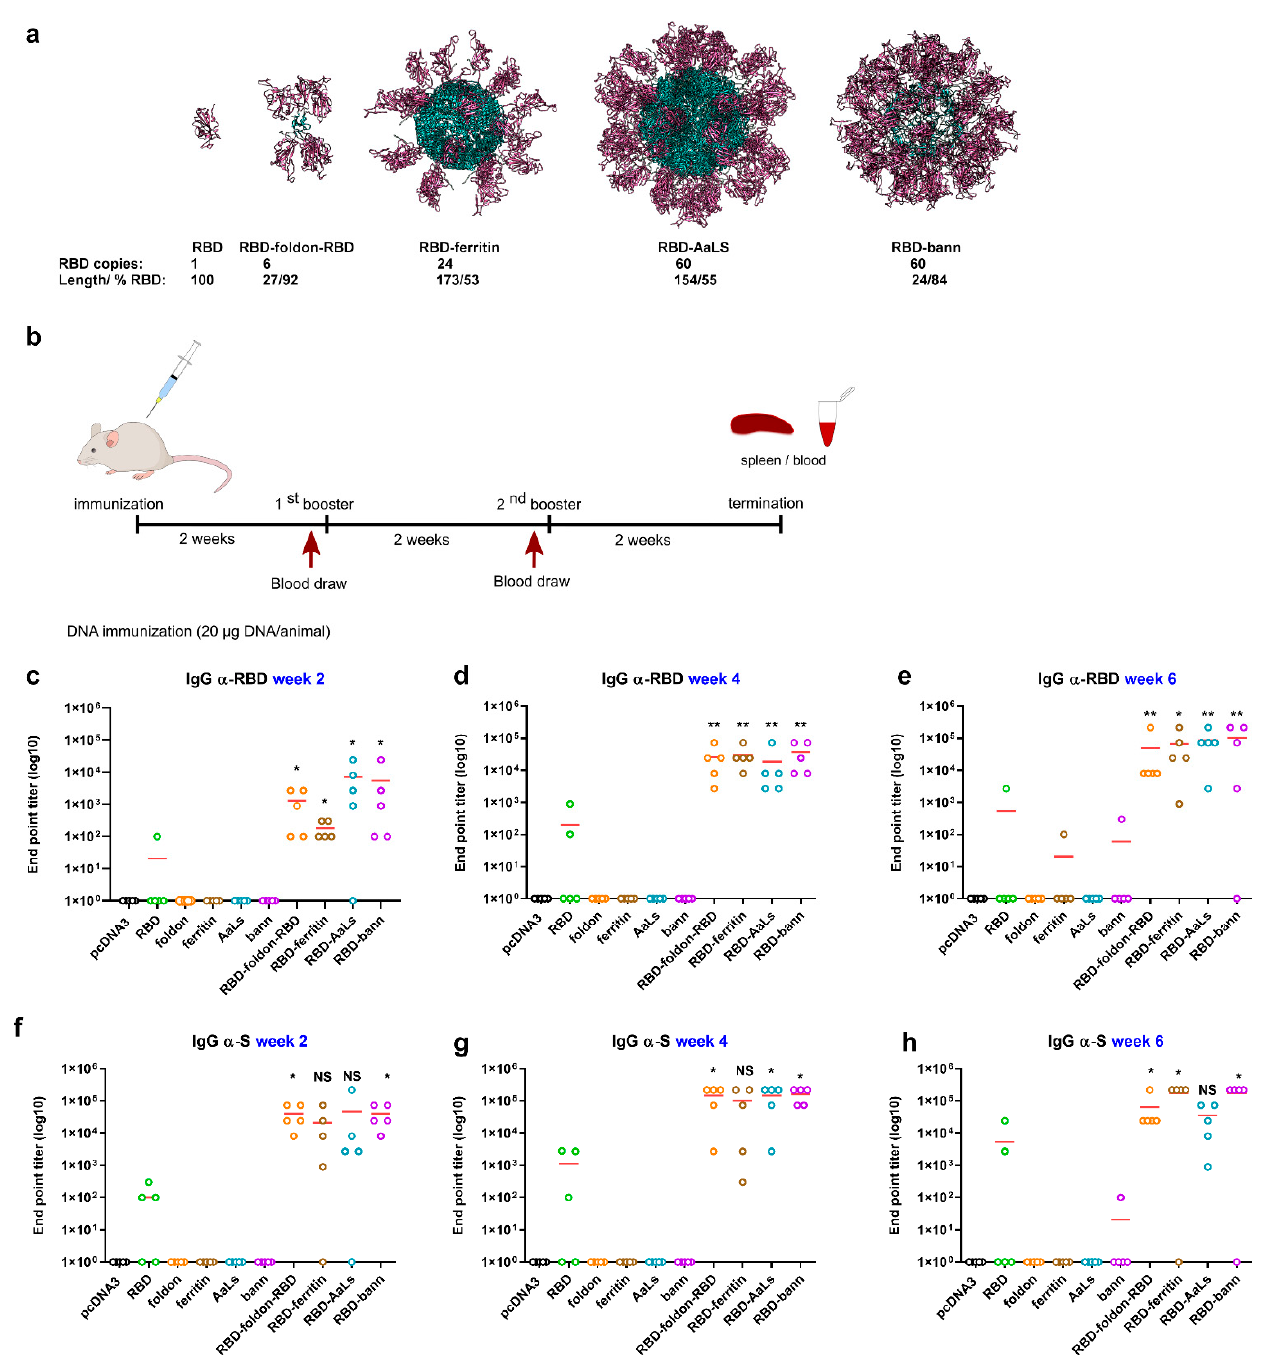
Figure 1. Scaffolded RBDs induce high titers of antibody production in vivo. Molecular models of RBD domains are shown in violet and scaffold cores in blue. The number of RBD domains per particle, length of the scaffolding domain, and fraction of amino acid residues of RBD in the assembly are listed below each model ( a ). Mice were immunized with plasmid DNA encoding RBD, scaffolded RBD variants, or scaffolds alone, according to the indicated immunization schedule ( b ). End point titer (EPT) values of total IgG against RBD ( c – e ) and against whole length spike protein ( f – h ) are shown. Graphs represent the mean EPTs of groups of mice ( n = 5 per group). Each dot represents an individual animal. * p < 0.05; ** p < 0.01. All p values are from the Mann-Whitney test compared to RBD group.